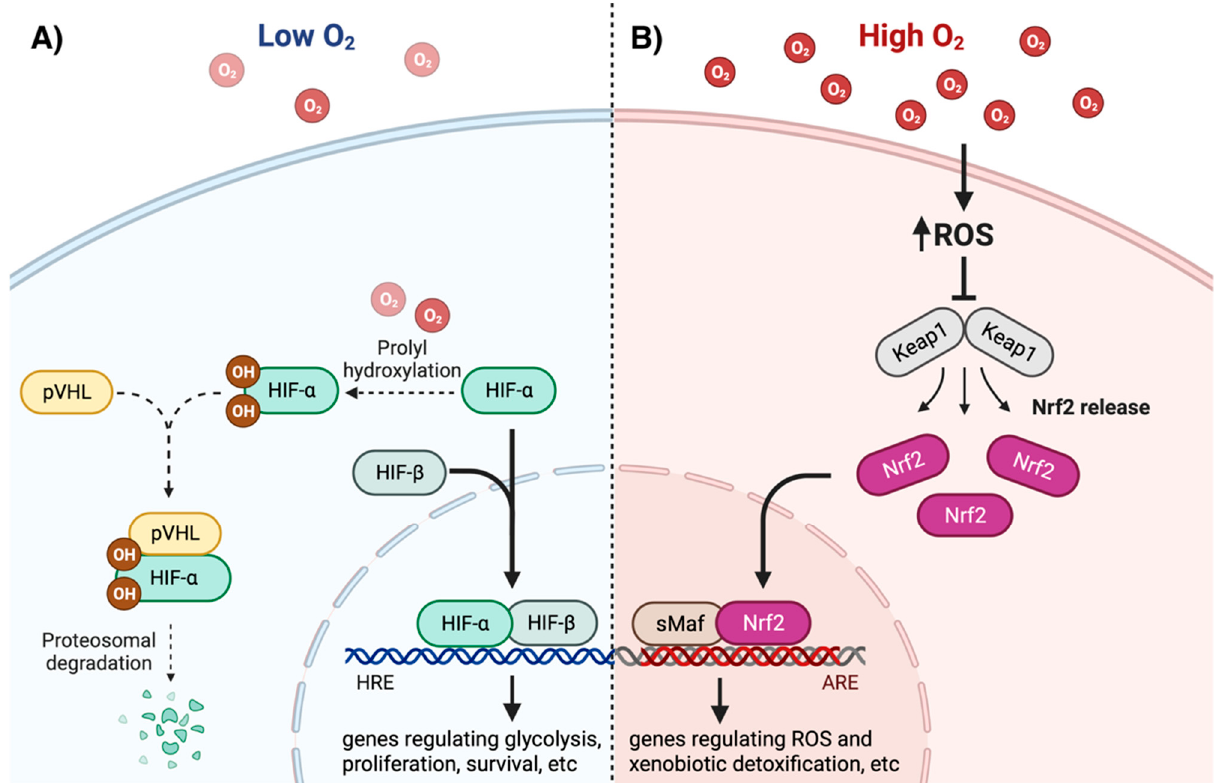
Figure 1. Pathways for intracellular oxygen/redox status sensing by HIF-1/2 and Nrf2. ( A ) Low O 2 levels reduce the rate of HIF-1/2 α hydroxylation, which leads to molecular recognition by the Von Hippel-Lindau tumor suppressor protein (pVHL) and subsequent proteasomal degradation. Stabilized HIF-1/2 α binds HIF- β and translocates to the nucleus, where it binds the hypoxia response element (HRE) in DNA, inducing expression of glycolytic, proliferative, and pro-survival genes, among others. ( B ) High O 2 levels promote increased reactive oxygen species (ROS) production. ROS-mediated oxidation of Keap1 releases Nrf2 preventing its proteasomal degradation. Nrf2 then translocates to the nucleus, heterodimerizes with small musculo-aponeurotic fibrosarcoma (sMaf),